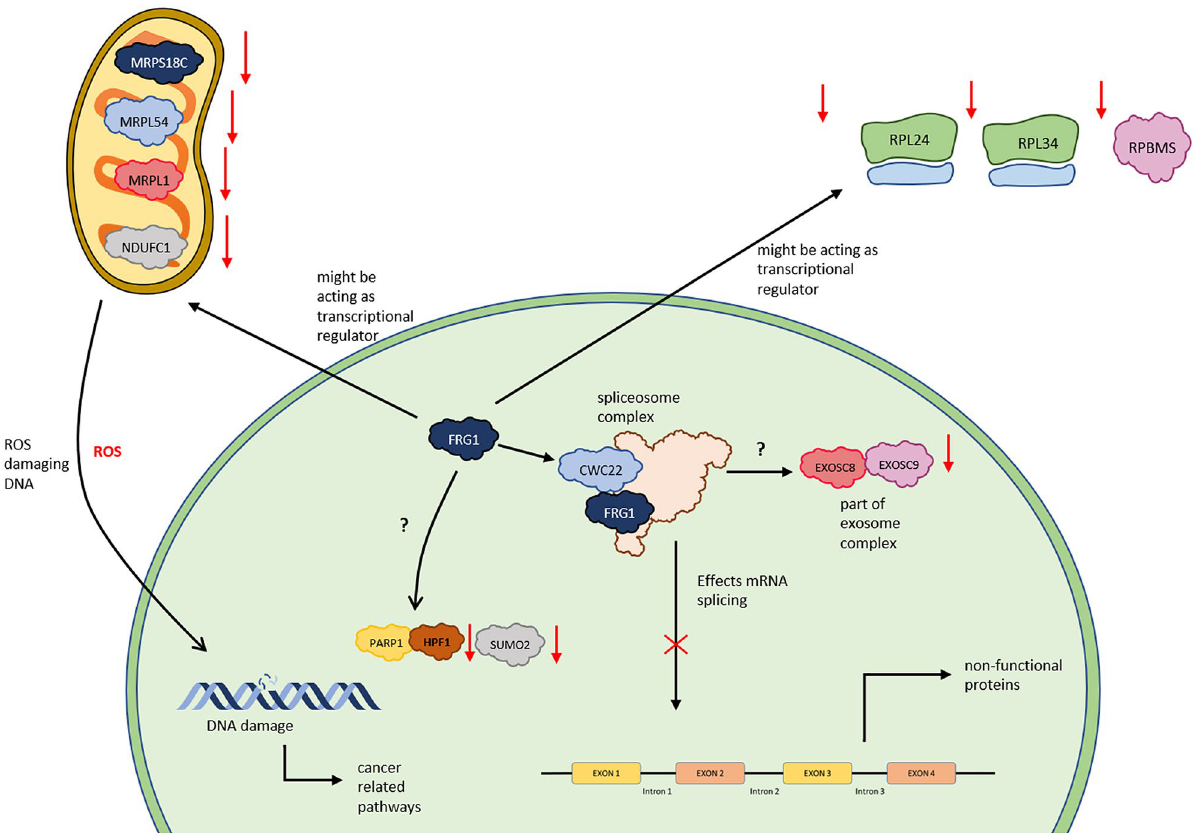
Figure 10. Hypothetical model showing functions of FRG1, based upon expression correlation and protein– protein interactions. Red downward arrows indicate the downregulation of expression, and the red cross shows